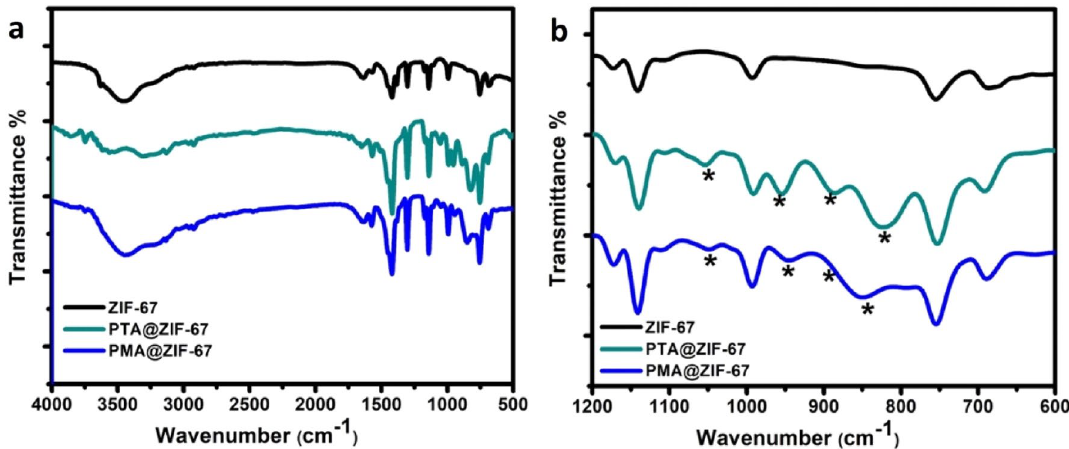
Figure 4. FTIR for pure ZIF-67, PTA@ZIF-67, and PMA@ZIF-67 MOF materials.